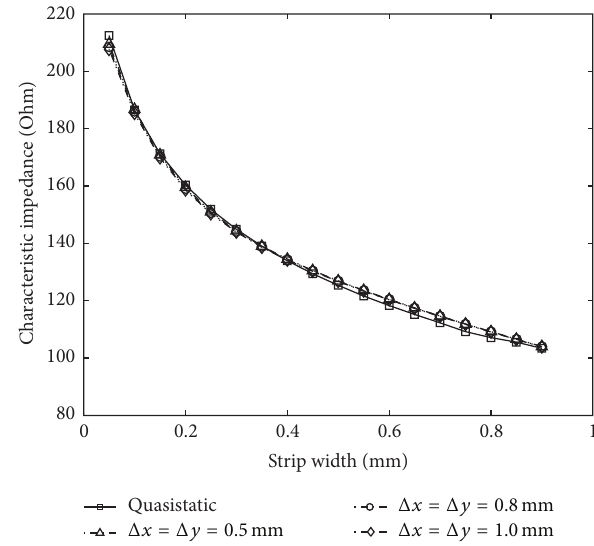
Figure 3: Calculated results of different methods.